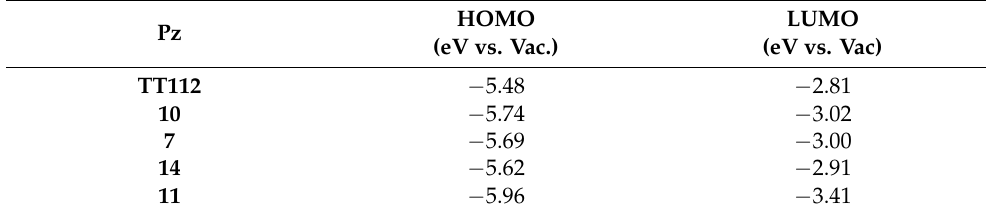
Figure 5. DFT predicted HOMO and LUMO orbitals and frontier orbital energy levels (M06/6-31G (d) for Pzs TT112, 7, 10 , 11 and 14 . The redox potential of the tri-iodide/iodide couple and the conduction band position of anatase titanium dioxide is represented for information. Table 2. Predicted energy levels (eV) of HOMO and LUMO orbitals of Pzs TT112 , 7, 10 , 11 and 14 by DFT